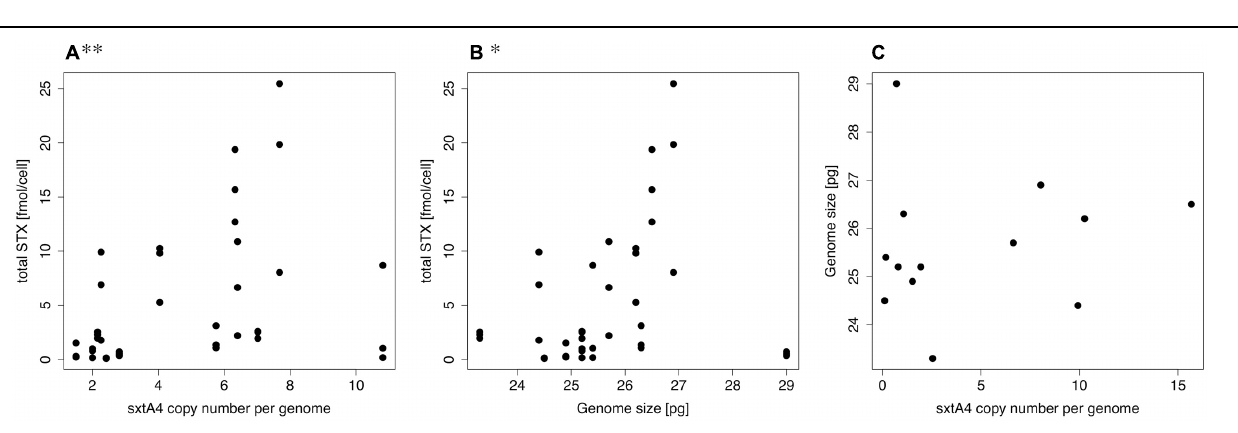
FIGURE 2 | Spearman rank order correlation plots. Scatterplots showing the relation between (A) sxtA4 copy number (CPN) per genome and total toxin content per cell, (B) total toxin content per cell and genome size, and (C) genome size and sxtA4 CPN per cell. CPN, copy number; significance level: ∗∗ p ≤ 0.01, ∗ p ≤ 0.05.